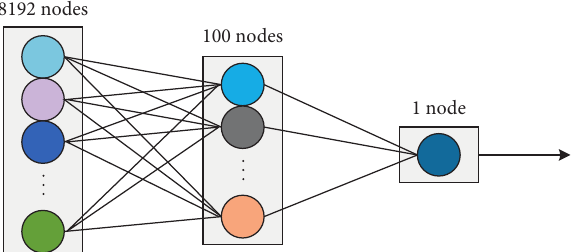
Figure 6: Illustration of the detailed FCL (fully connected layer). The first column contains 8192 nodes, the second column contains 100 nodes, and the third column contains only one